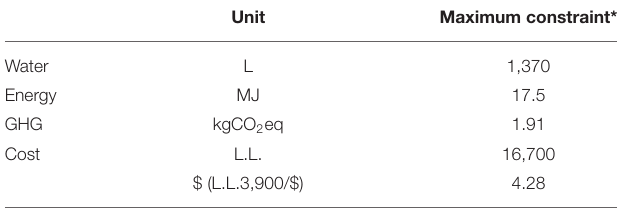
TABLE 3 | Environmental footprints and cost maximum constraints.